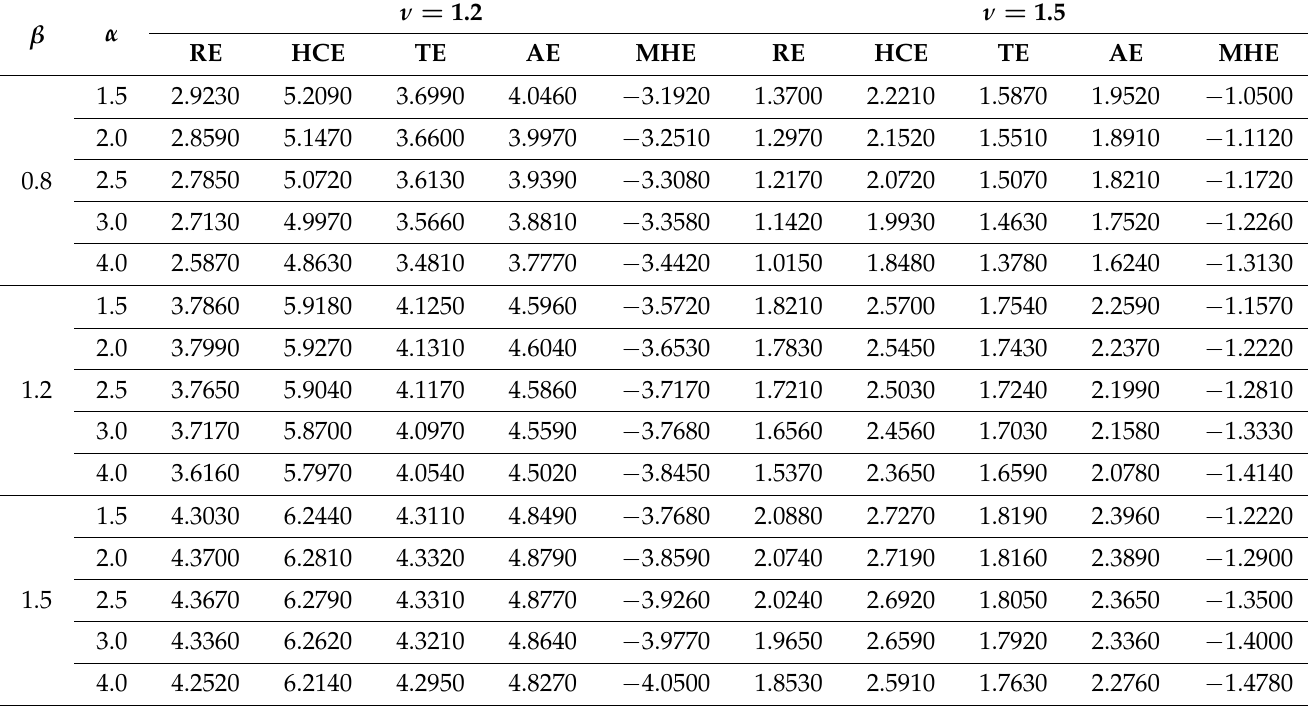
Table 3. Some numerical values of entropy for the UEPD at λ = 0.5, ν = 1.2 or